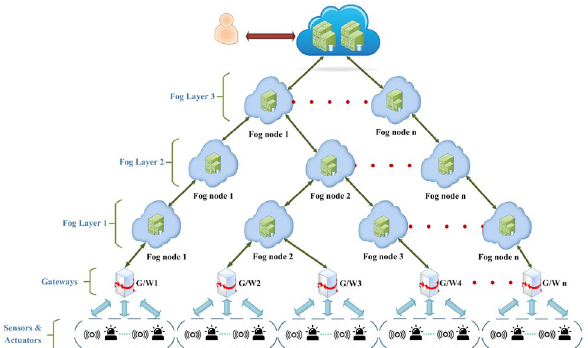
Figure 1. SALFSD